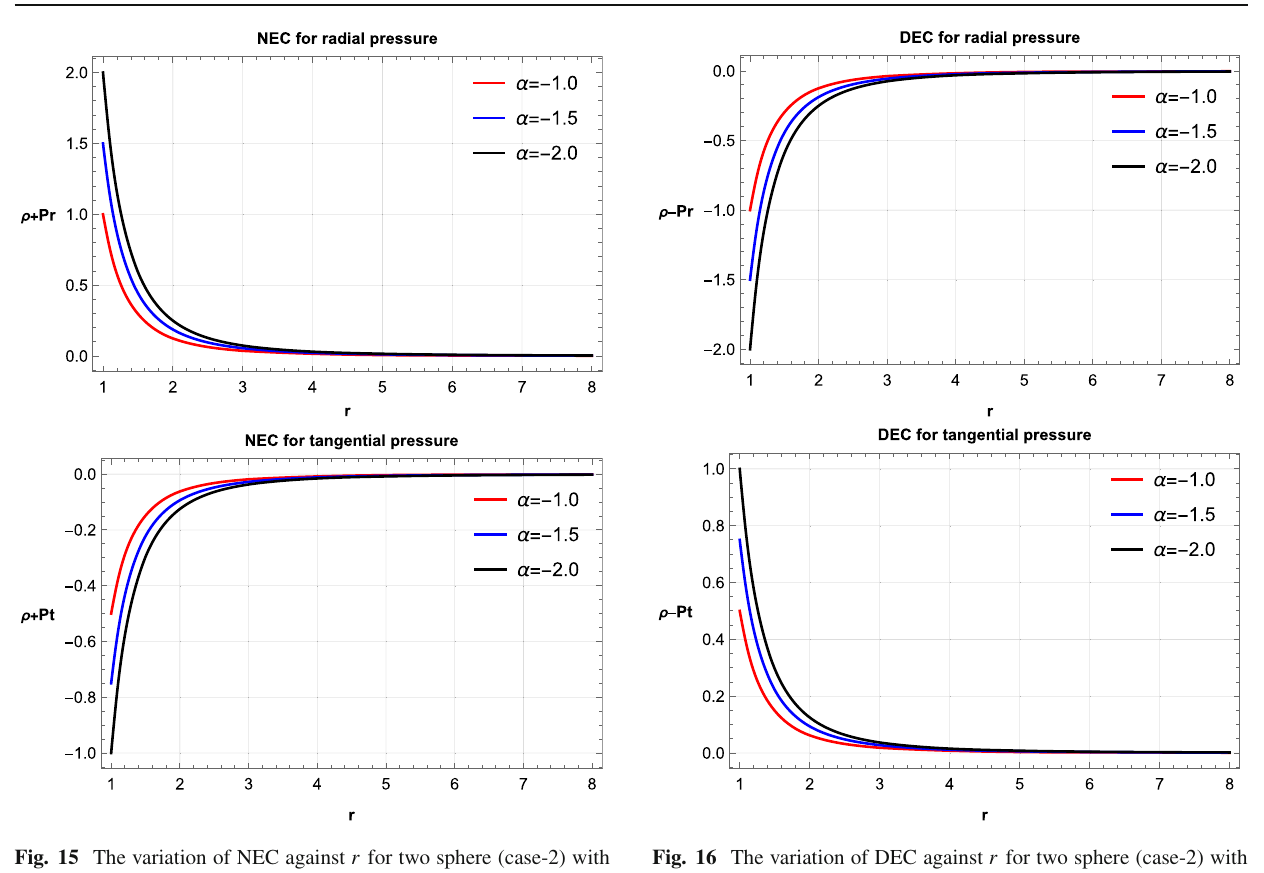
Fig. 15 The variation of NEC against r for two sphere (case-2) with r 0 = 1 and D = 20